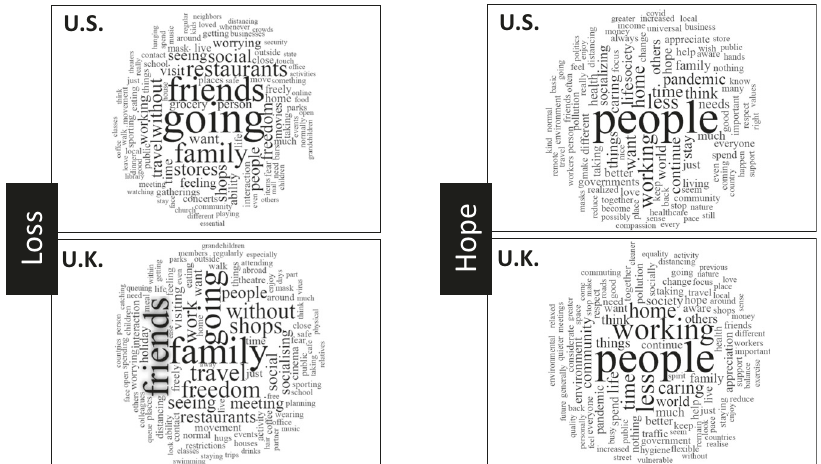
Fig. 4 Experiment 1: Word clouds computed by Nvivo 12 of open-ended responses to three questions for both samples. Left panels: responses to the question What do you most miss from life before the pandemic? Right panels: responses to the questions What is different now — about your life, about society, about the world — that you would like to stay different after the pandemic? and What would you like to be different — about your life, about society, about the world — after the pandemic compared to before? (right). All stemmed words over four letters long were included, except for a limited list of stop words and words that replicate the language of the question (e.g., “ miss ” for the fi rst question was removed from these responses). See text for